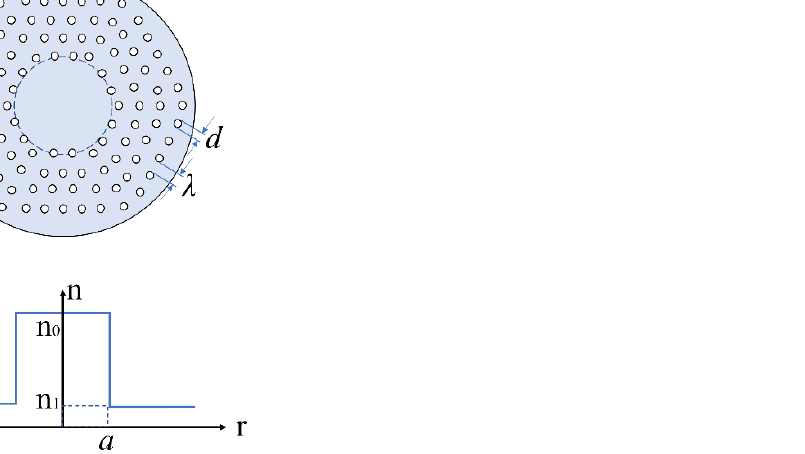
Figure 1. ( a ) Cross-section of multimode SI mPOF, ( b ) refractive-index profile of the referent multi- mode SI mPOF.